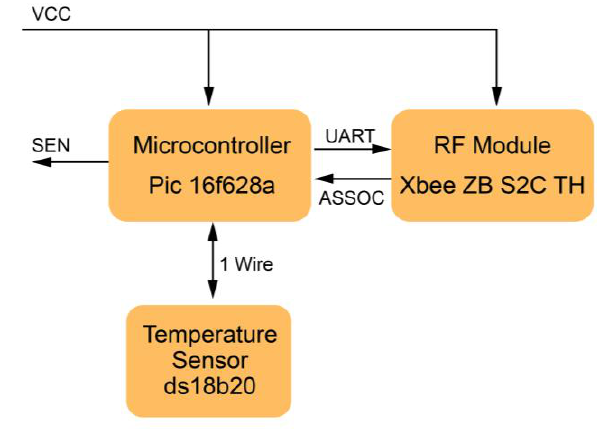
Figure 3. Load block diagram.